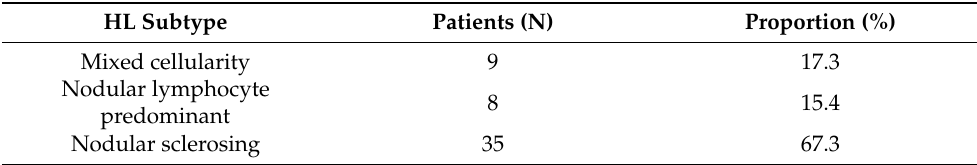
Table 1. Percentage distribution of the patient sample according to HL subtype.